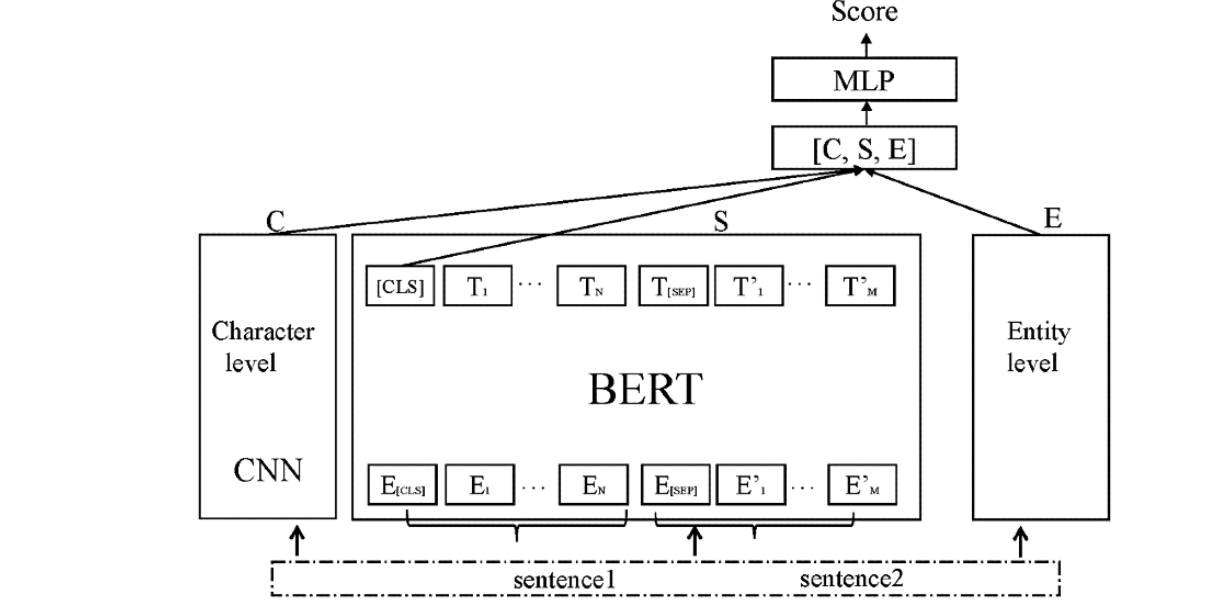
Figure 1. Overview architecture of our model for the ClinicalSTS track of the 2019 n2c2/OHNLP challenge. BERT: bidirectional encoder representation from transformers; ClinicalSTS: clinical semantic textual similarity; CNN: convolutional neural network; MLP: multilayer perceptron; PCC: Pearson correlation coefficient; [CLS]: the representation of sentence pair with